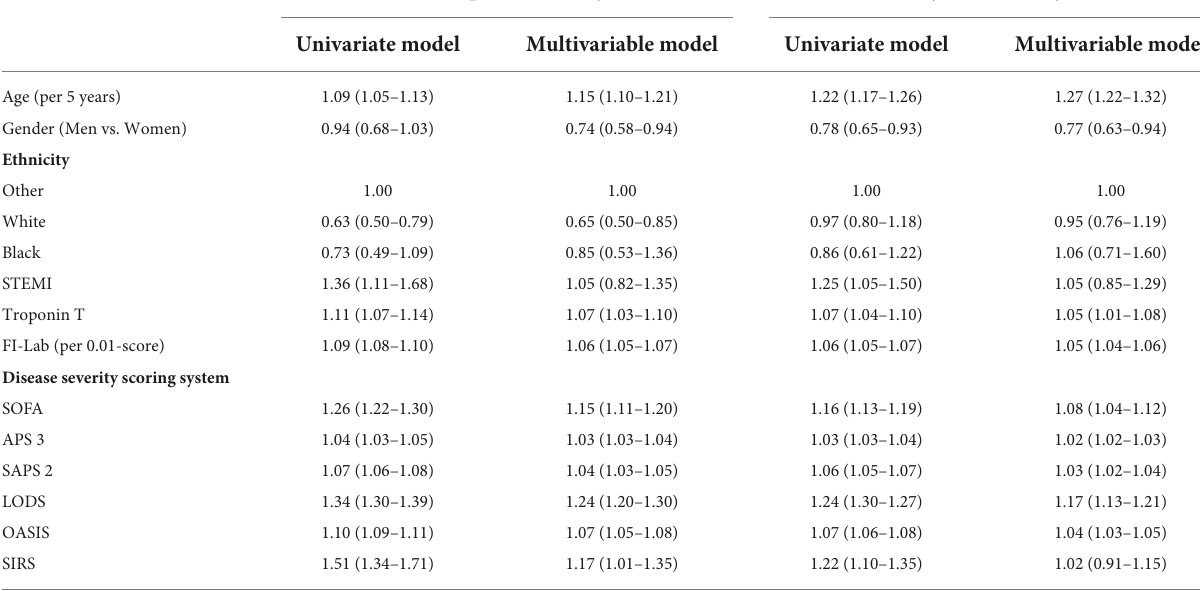
TABLE 2 Association of baseline characteristics with in-hospital and 1-year